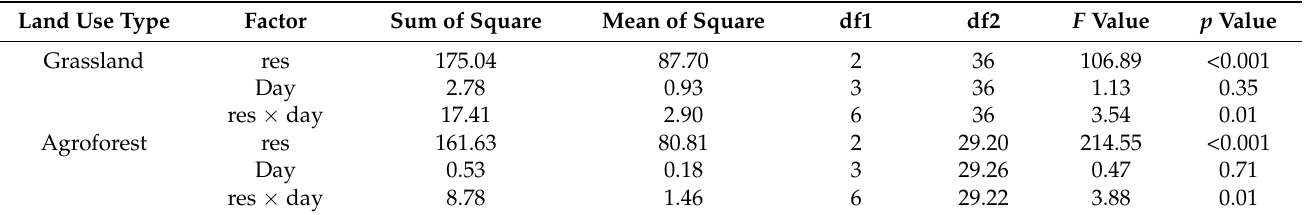
Table 3. Linear mixed-effect model table of type III error for the effect of basal resources and the soil, sampling day and their interaction on the incorporation of 13 C into different plant parts and into the soils of grassland and